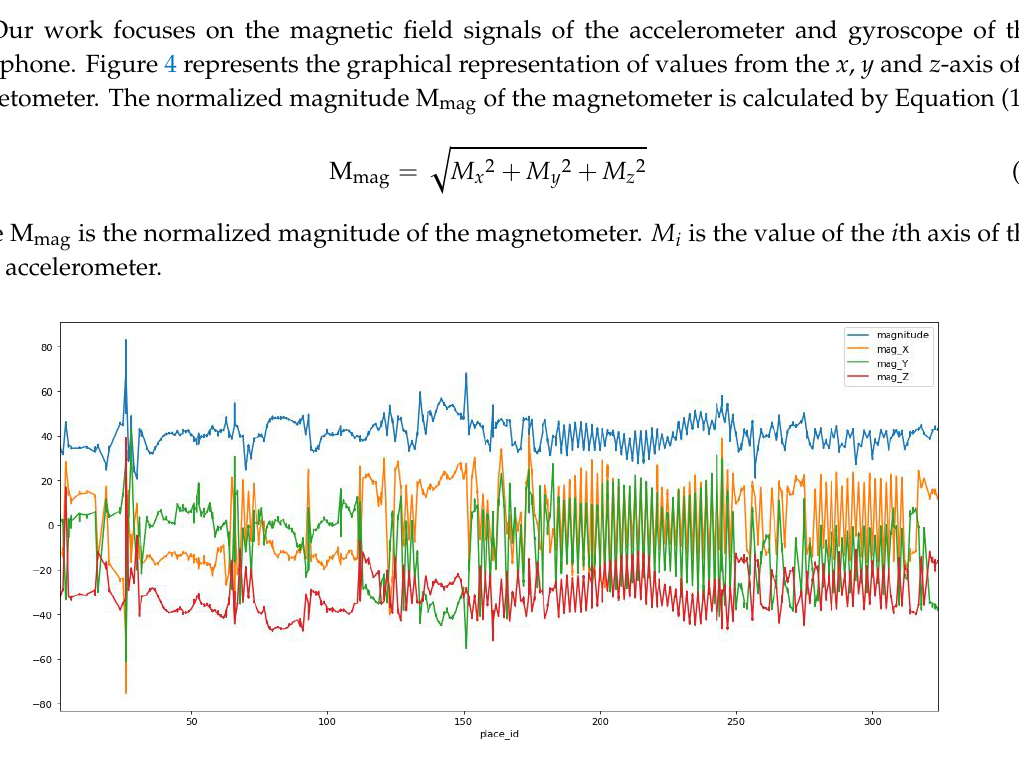
Figure 4. Graphical representation of the x , y , and z coordinates and magnitude of the magnetometer readings.